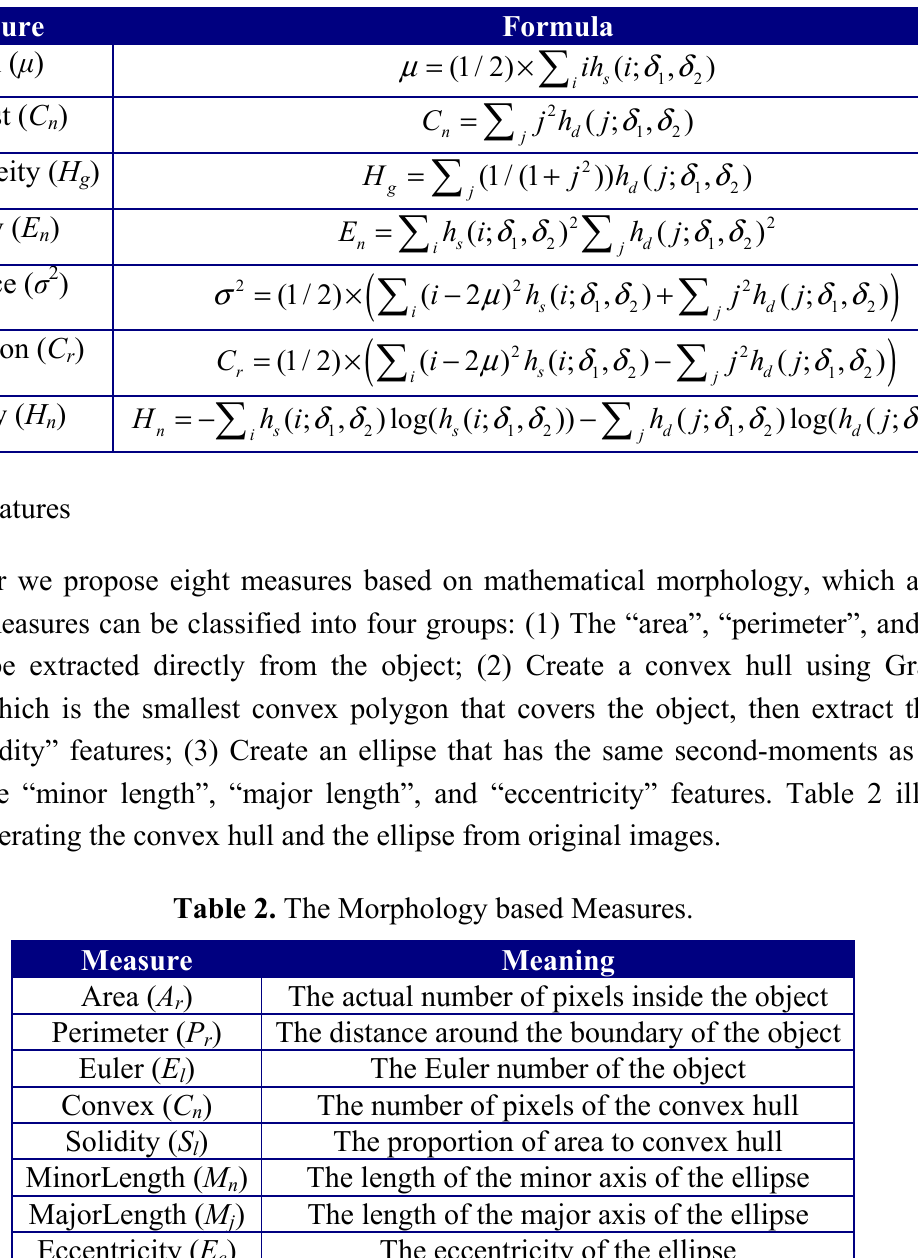
Table 1. Sum and difference histogram based measures.